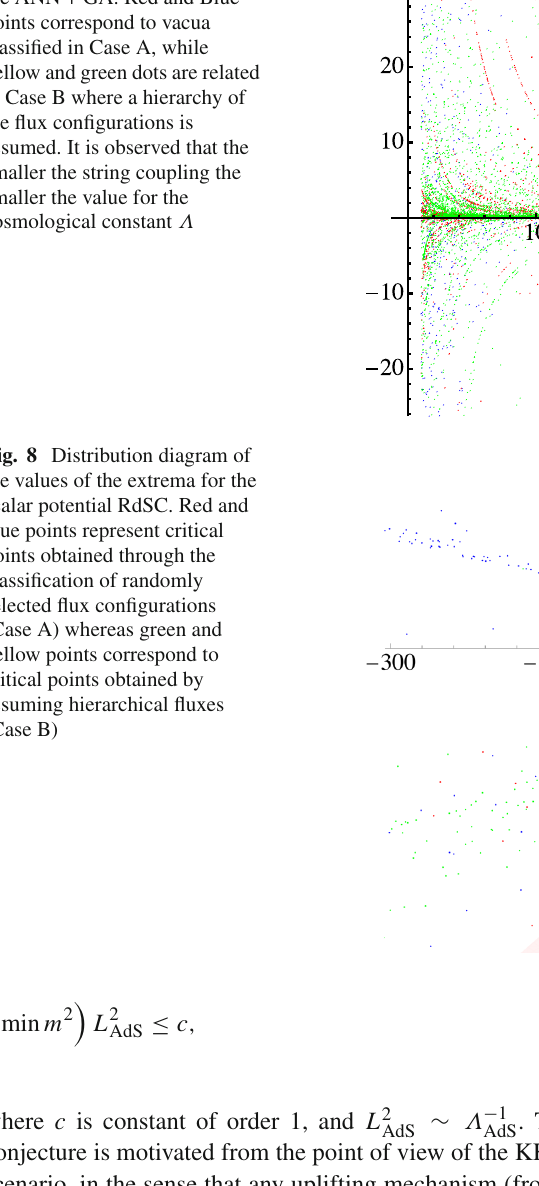
Fig. 7 Value of the scalar potential versus the string coupling at the critical point for all analyzed cases produced by the ANN + GA. Red and Blue points correspond to vacua classified in Case A, while yellow and green dots are related to Case B where a hierarchy of the flux configurations is assumed. It is observed that the smaller the string coupling the smaller the value for the cosmological constant Λ